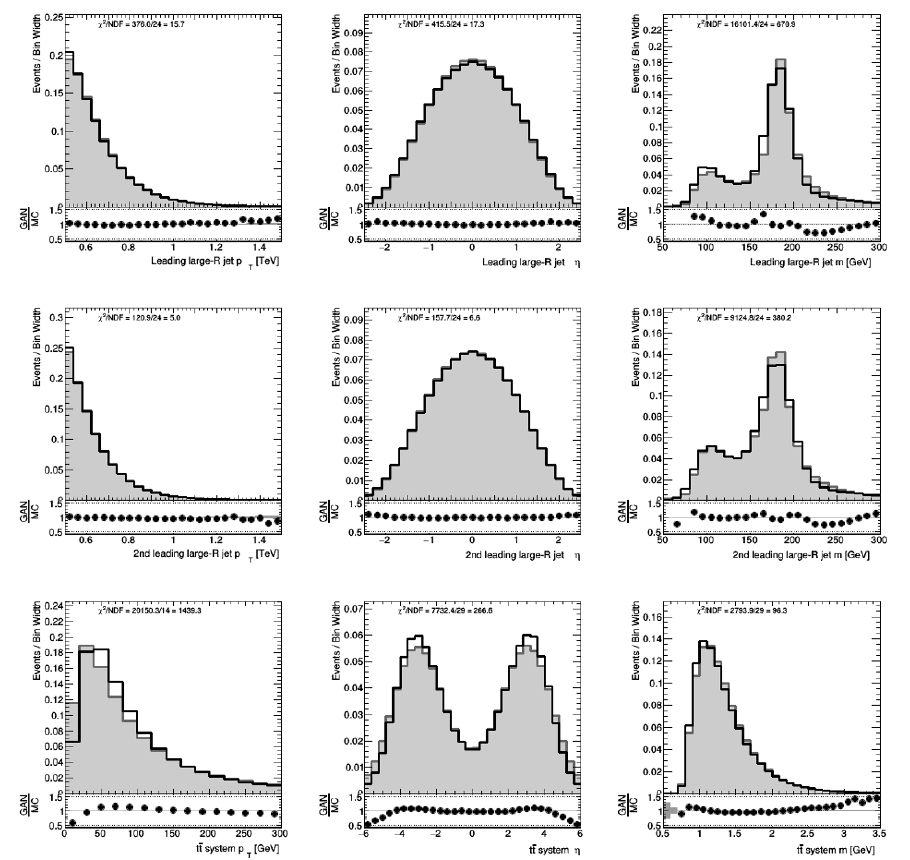
Figure 8 . Comparison of kinematic observables for the all-hadronic t (cid:22) t production with respect to particle-level ( MadGraph5 + Pythia8 ) Monte Carlo simulation. The gray area represents the MC prediction, and the black line indicates the GAN